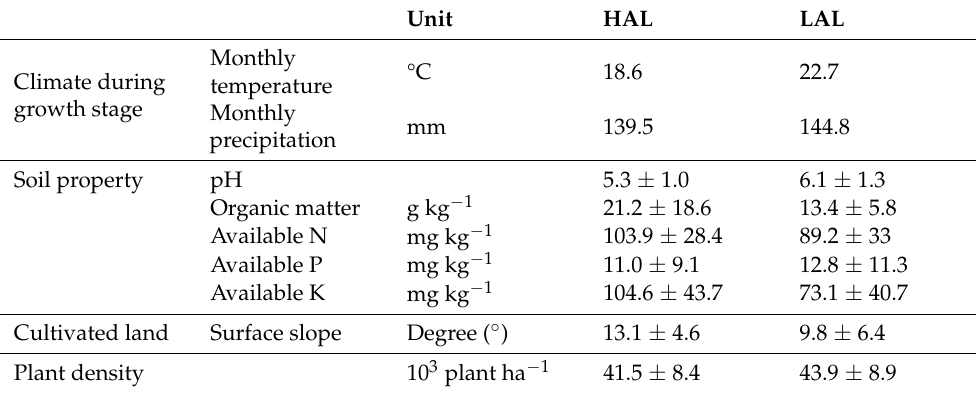
Table 1. The climate during the growth stage, soil property and plant density of open-field pep- per production in HAL and LAL. HAL represents the high-elevation level (500–800 m), and LAL represents the low-altitude level (900–1200